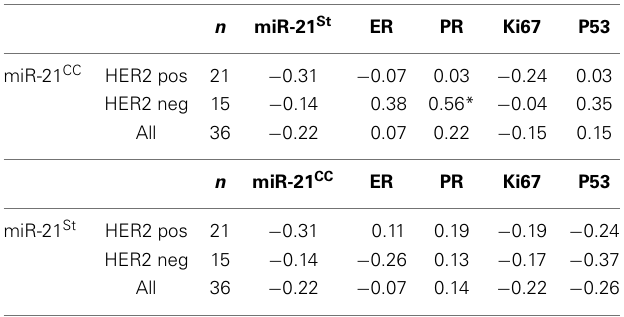
Table 2 | Correlation analyses